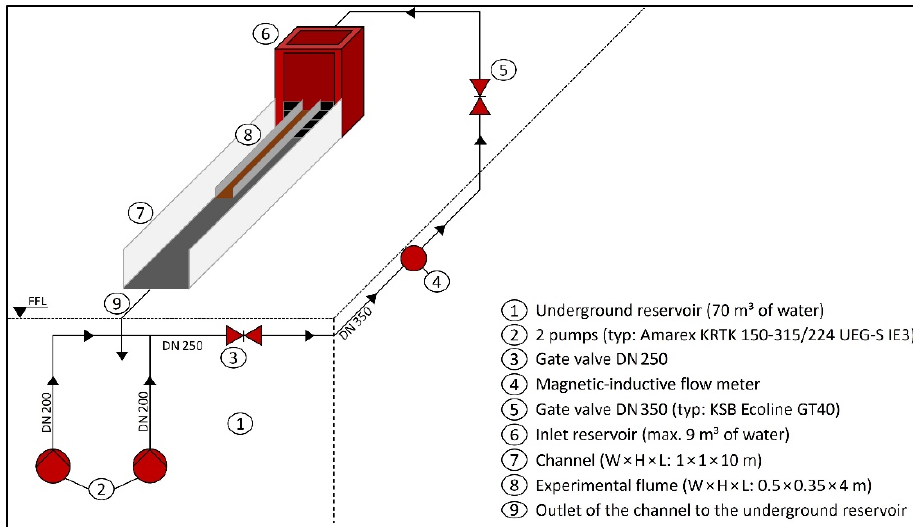
Figure 1. Sketch of the experimental setup.